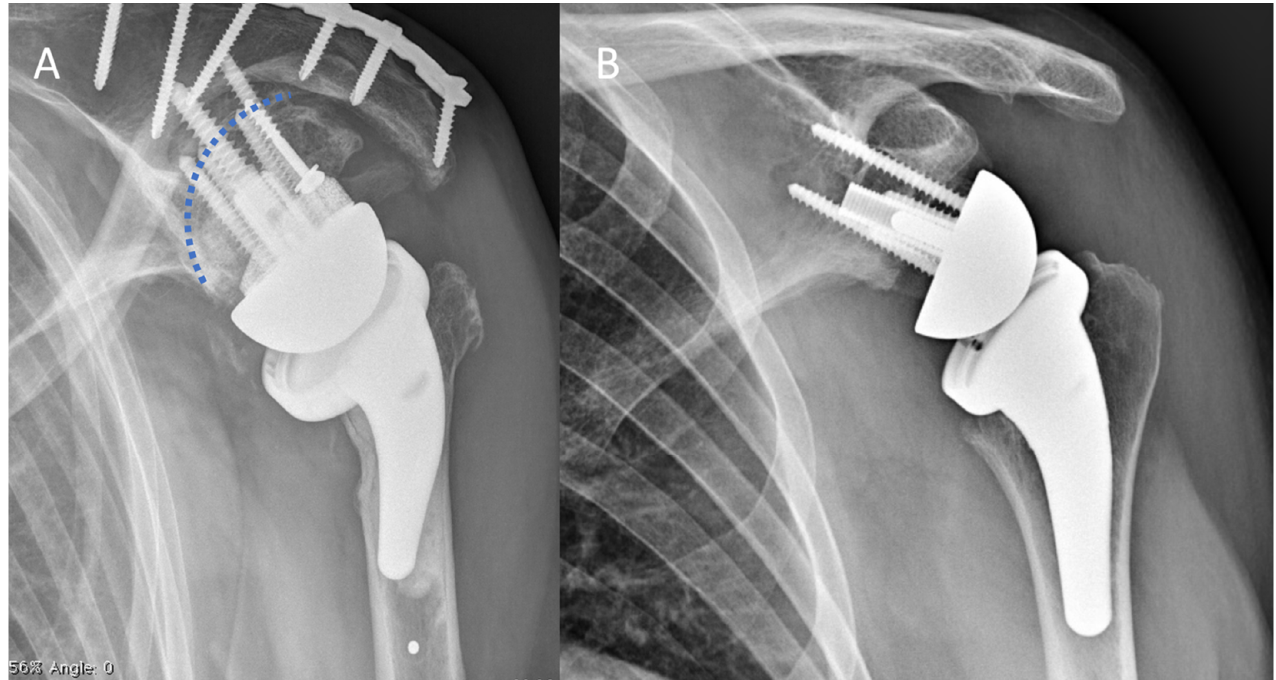
Figure 2. Postoperative anteroposterior X-ray of left shoulders. ( A ) Reconstruction of the glenoid with BMA and a 15 degrees full wedge augmented central screw baseplate. The dotted blue line represents the native glenoid. There is concurrent plate fixation of a preoperative fatigue fracture of the spine of the scapula. ( B ) Reconstruction of the glenoid with BA and a 25-mm-long central peg baseplate.